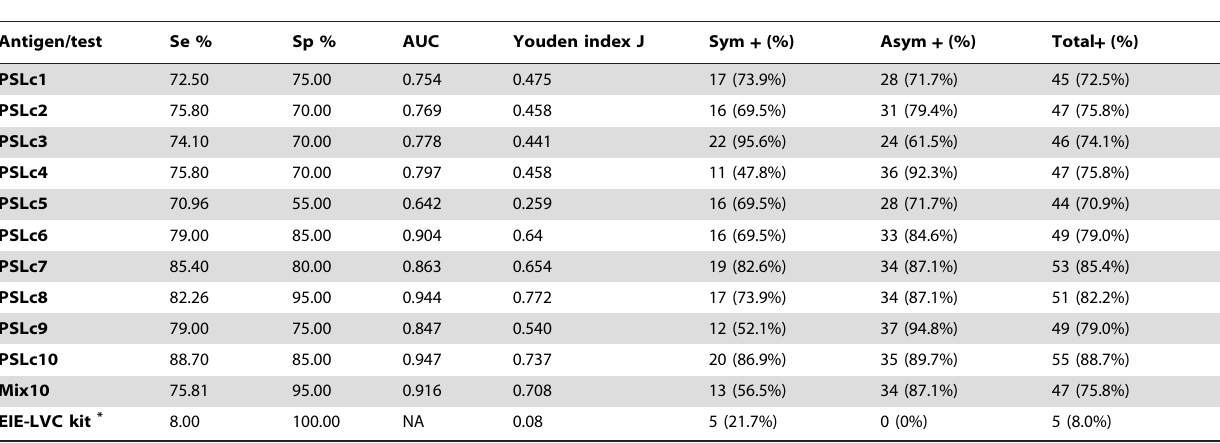
Table 1. Diagnostic performance of EP and EIE-LVC kit in serum samples from symptomatic and asymptomatic dogs.